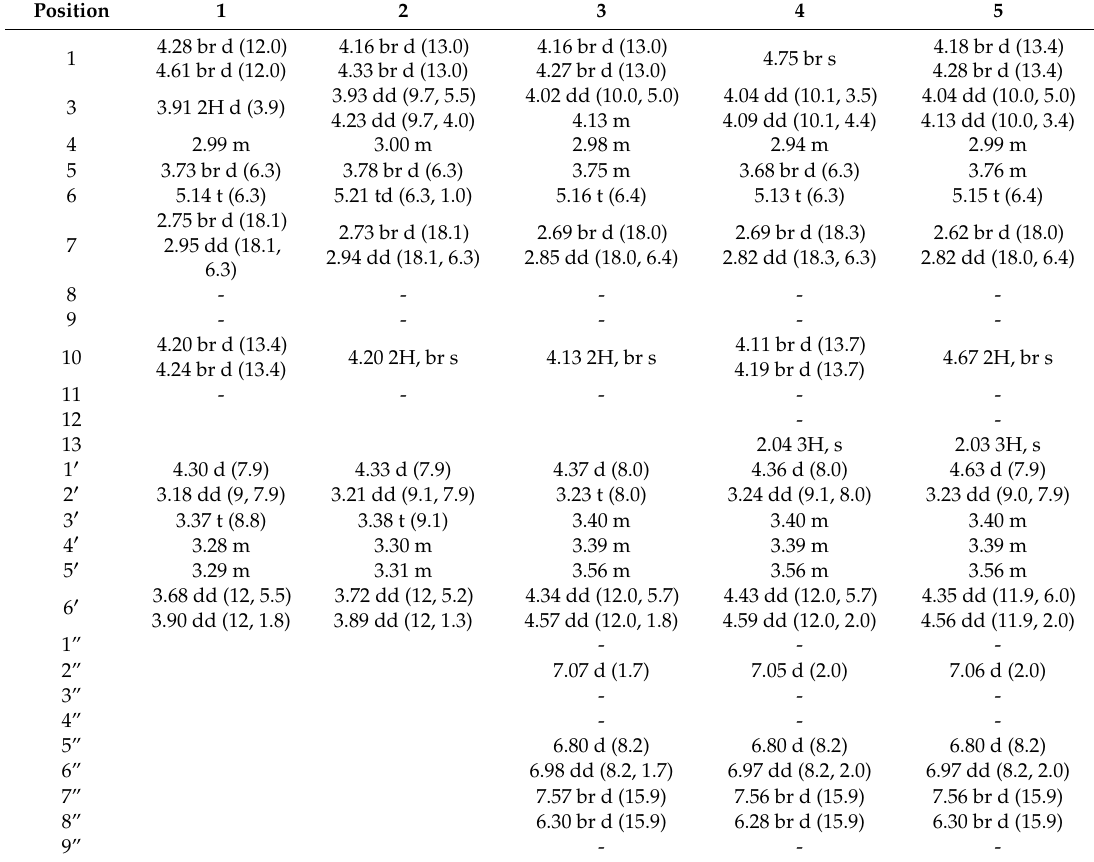
Table 1. 1 H NMR data of compounds 1 – 5 (500 MHz, CD 3 OD, δ in ppm, J in